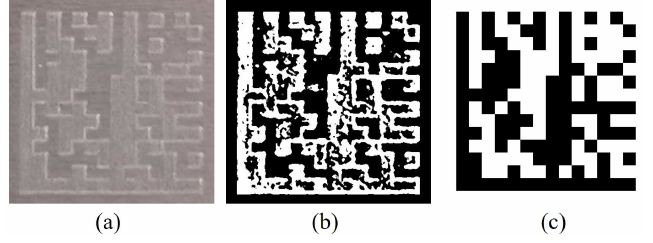
Figure 19. ( a ) Original barcode image; ( b ) binarization result of Yang [15]; ( c ) our